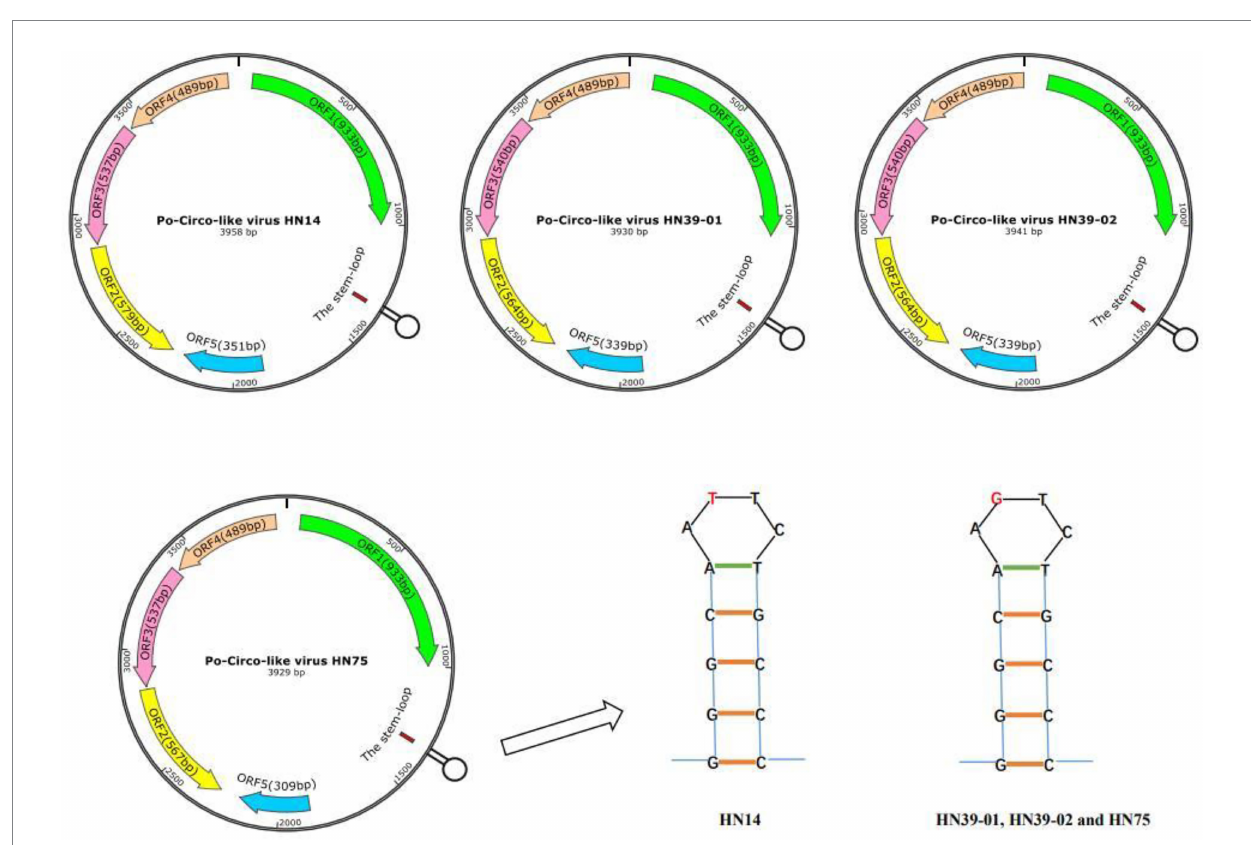
FIGURE 1 Predicted genome organization of the Po-Circo-like virus and the stem loop of the Po-Circo-like